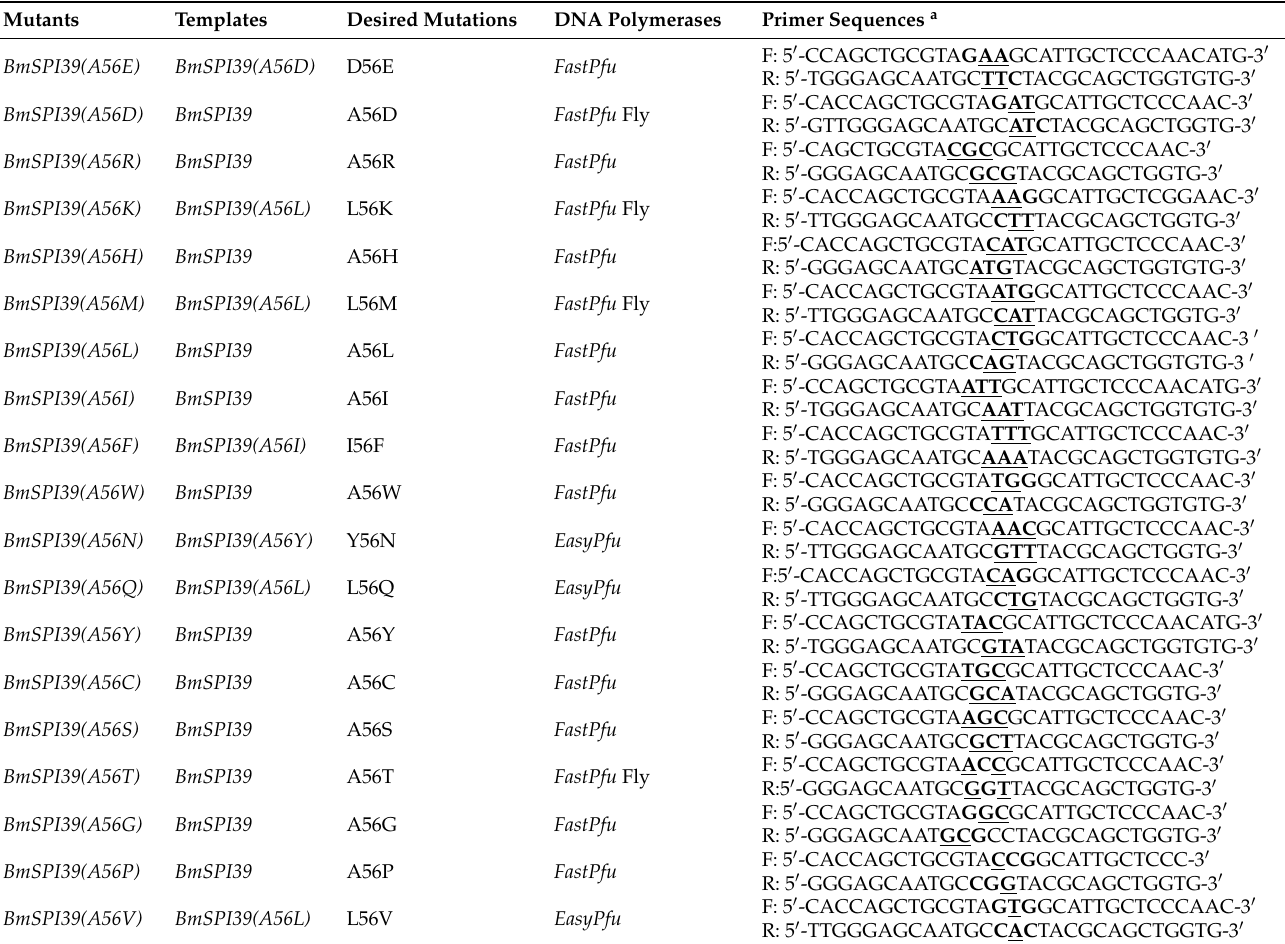
Table 2. Mutagenic primers at P1 position of